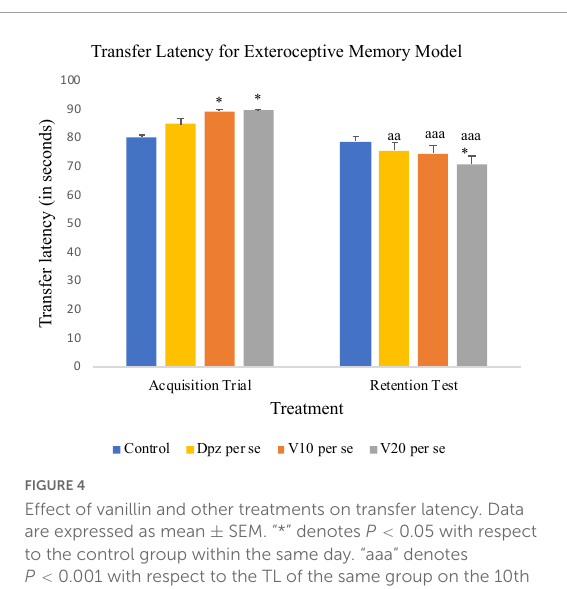
FIGURE4 Effect of vanillin and other treatments on transfer latency. Data are expressed as mean ± SEM. “*” denotes P < 0.05 with respect to the control group within the same day. “aaa” denotes P < 0.001 with respect to the TL of the same group on the 10th day of the treatment, and “aa” denotes P < 0.01 with respect to the TL of the same group on the 10th day of the treatment.